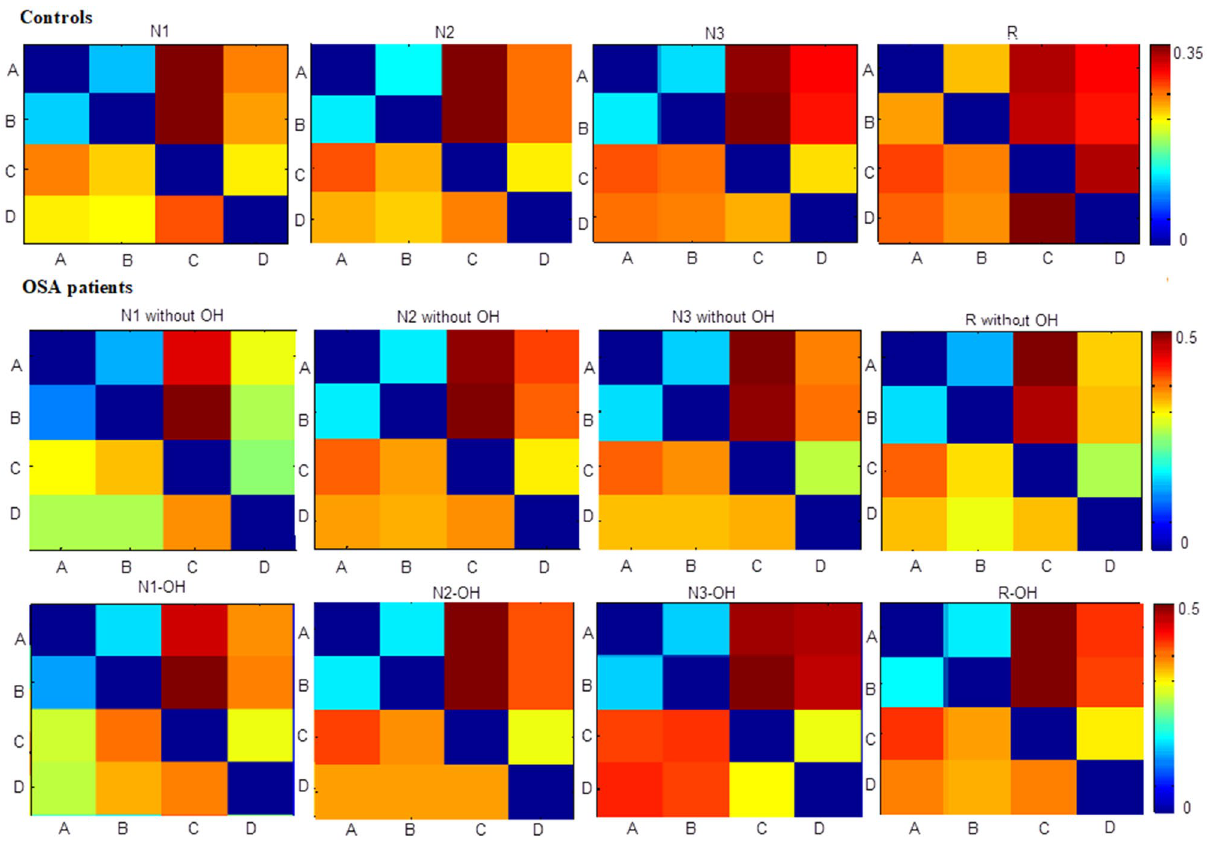
Figure 2. Transition probabilities (TP) of 4 microstates in controls, OSA_OH and OSA_withoutOH